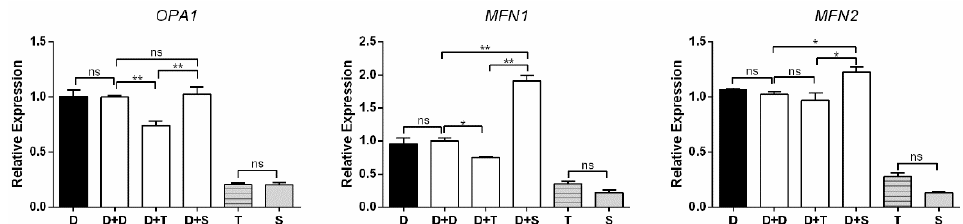
Figure 6. Expression levels of three mitochondrial fusion-related genes in primary cells and cybrids. Black columns: DF-1 cells and primary cells; white columns denote cybrids. n = 3 per group. * means p < 0.05, ** means p < 0.01, and ns means p > 0.05.